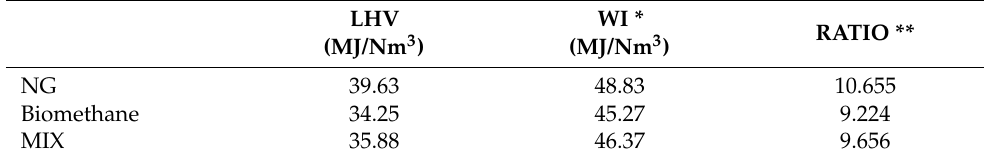
Table 1. Volume compositions of average NG, average biomethane and MIX (X = 0.698).